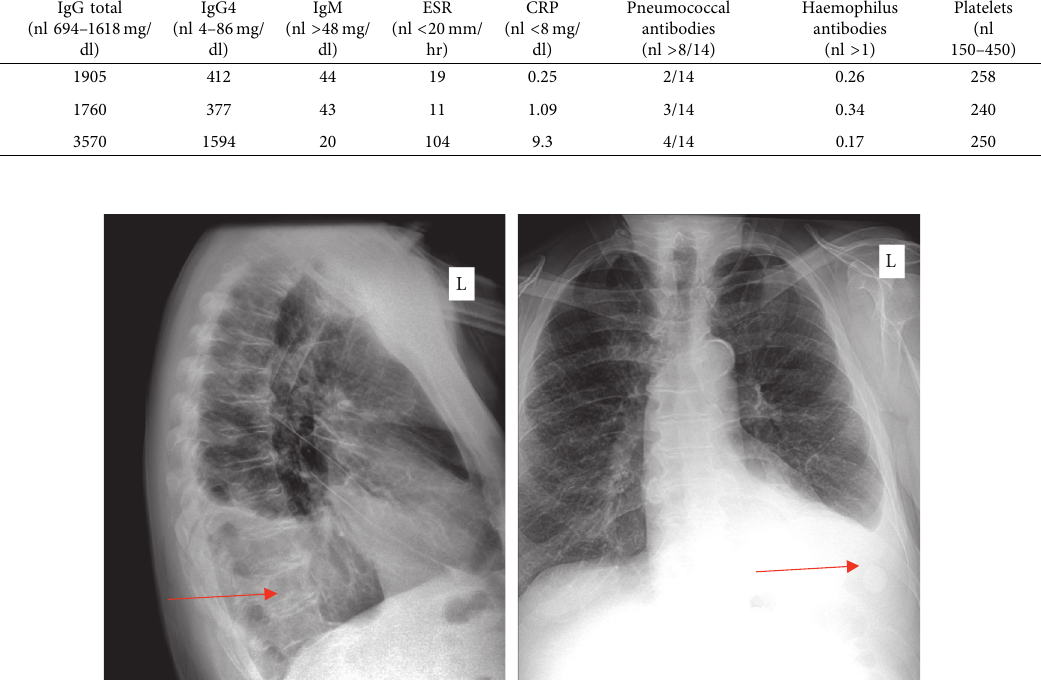
Table 1: Laboratory values at presentation, several months into treatment while on corticosteroids and mycophenolate mofetil, and during relapse.